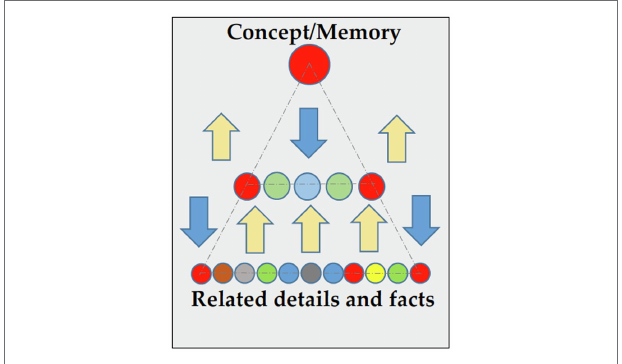
FIGURE 1 | Distributive and associative ways of information storage and retrieval. Figure © 2017 IEEE. Reprinted, with permission, from (Yas¸ar,